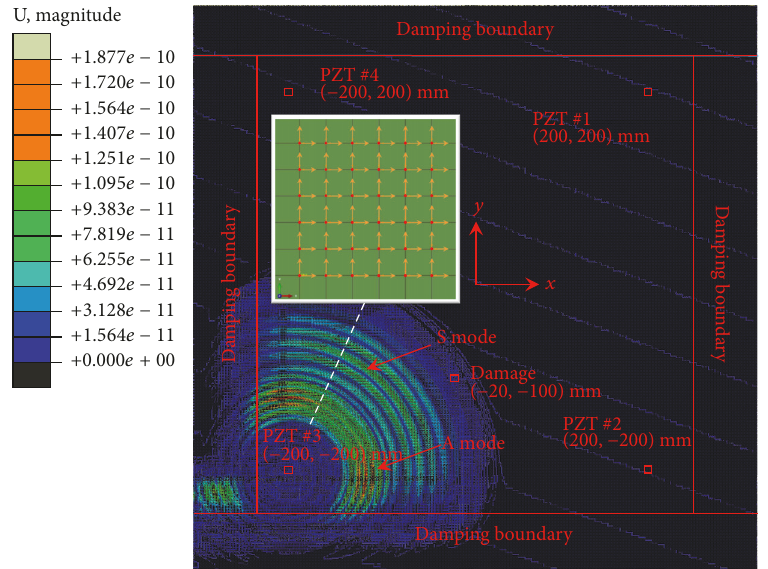
Figure 8: Wave excitation in FE model.